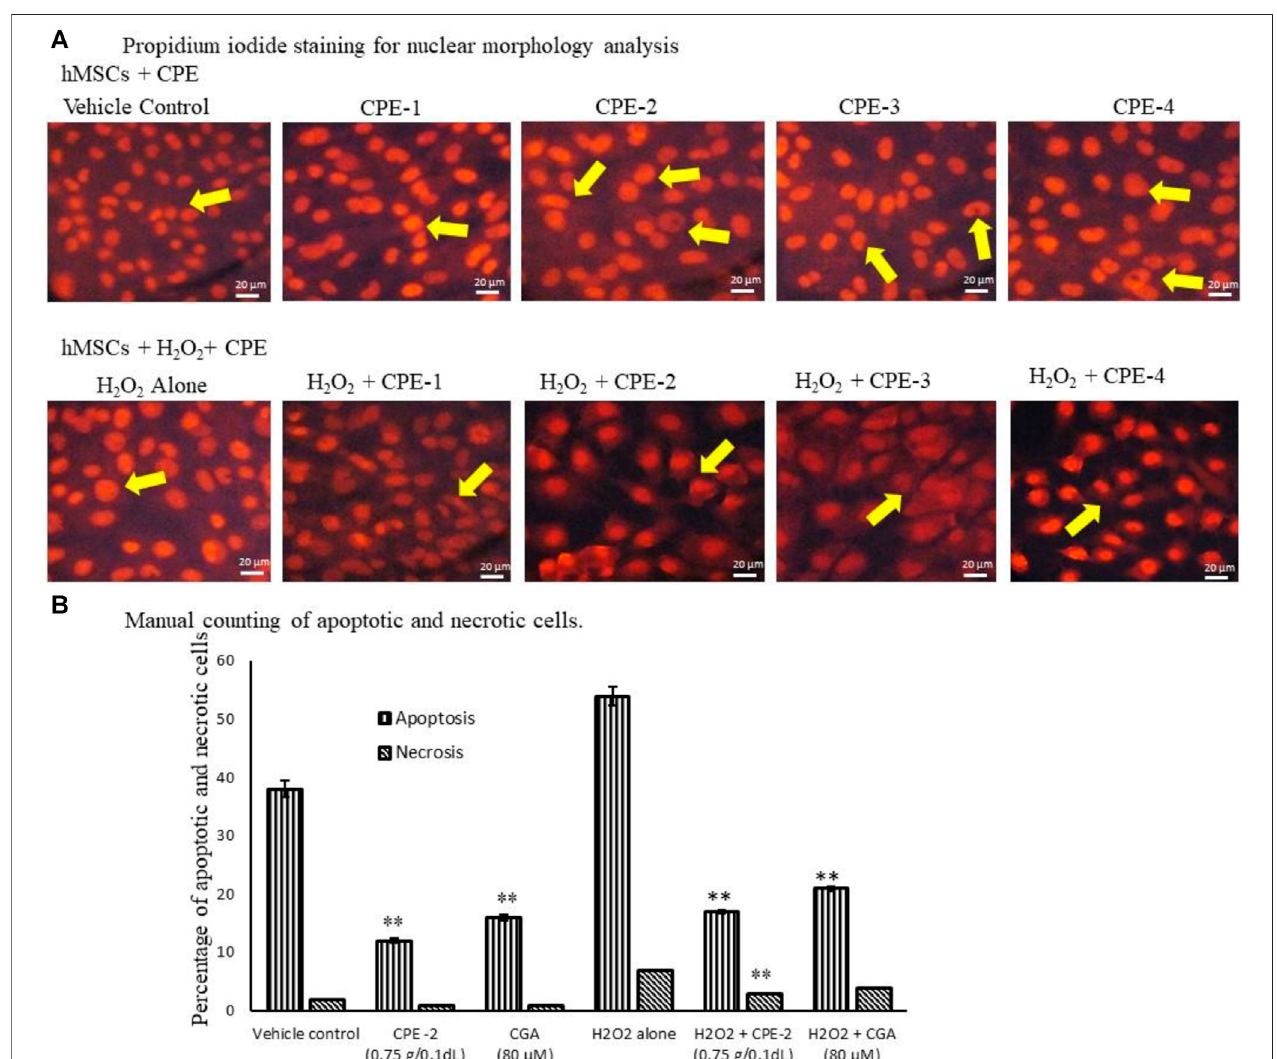
FIGURE 5 | Analysis of vehicle control and CPEs – treated hMSCs nuclear morphology by PI Staining for nuclear damage (A) and manual counting for apoptotic or necrosiscells (B) after48 h.Alltheimageswerecaptured with × 20magni fi cation.CPE-1 (cid:1) 0.5 g,CPE-2 (cid:1) 0.75 g,CPE-3 (cid:1) 1 g,and CPE-4 (cid:1) 1.25 g.Each ofthevalues are mean ± SD ( n (cid:1) 6). * p ≤ 0.05 and ** p ≤ 0.001 were compared with vehicle control or H 2 O 2 alone treated hMSCs.